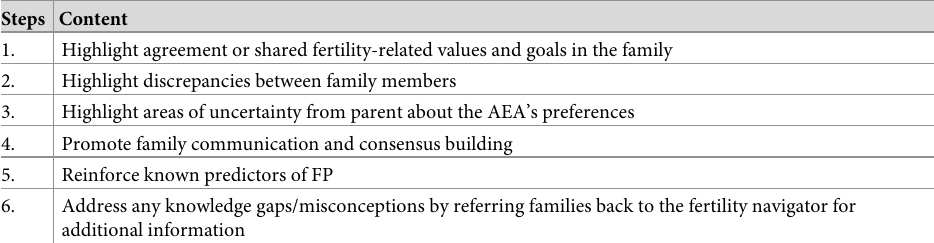
Table 2. Guided discussion